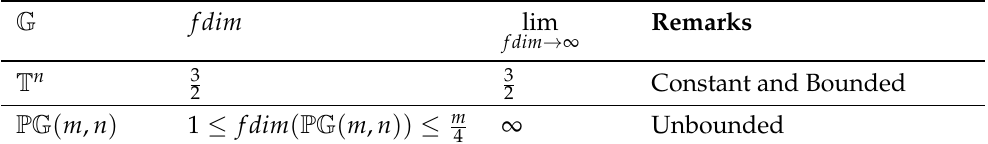
Table 22. Summary of obtained